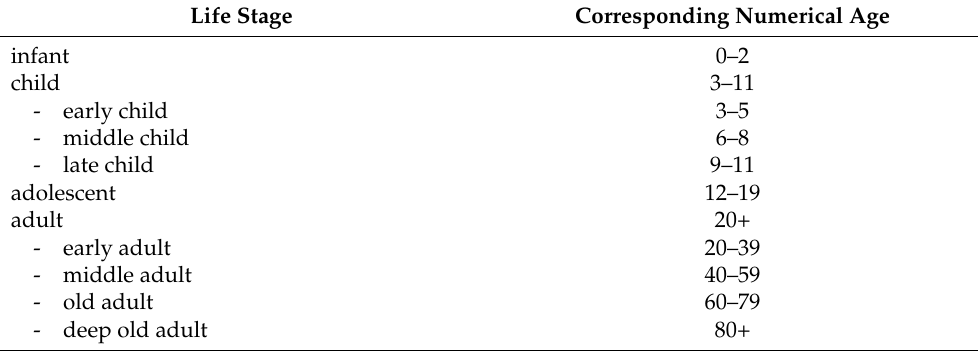
Table 1. Age scheme used for the annotations, categorizing numerical ages into categories of life stages. Life Stage Corresponding Numerical Age infant